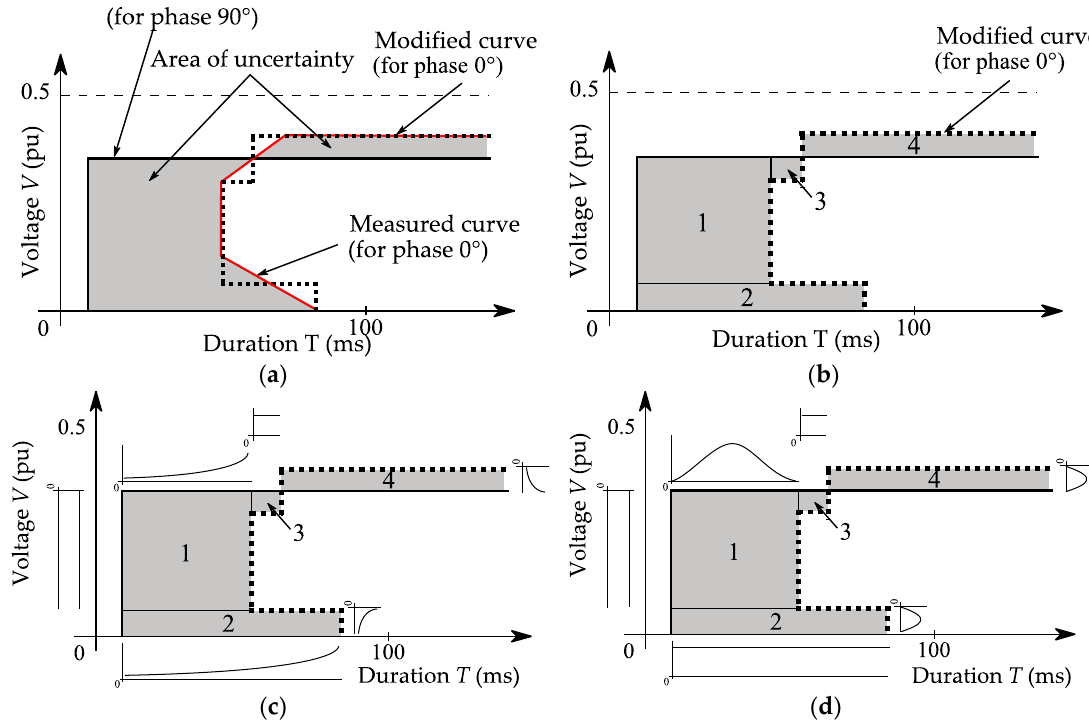
Figure 6. Area of uncertainty for contactors: ( a ) theoretical area of uncertainty for contactors; ( b ) area of uncertainty distribution; ( c ) considering the combination of uniform and/or exponential distribution in the individual sub-regions; and ( d ) considering the combination of uniform and/or normal distribution in the individual sub-regions.